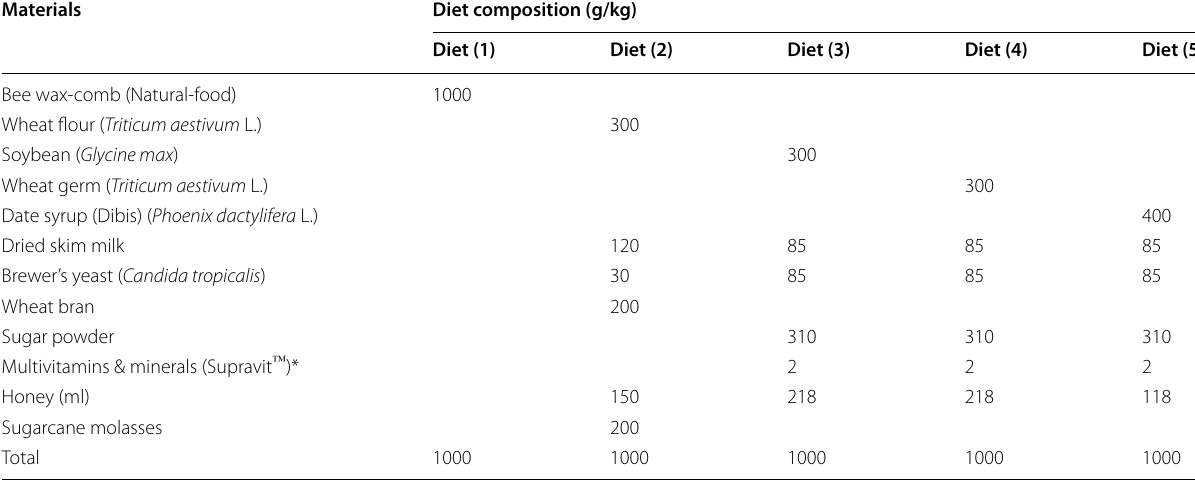
*Produced by GlaxoSmithKline S.A.E